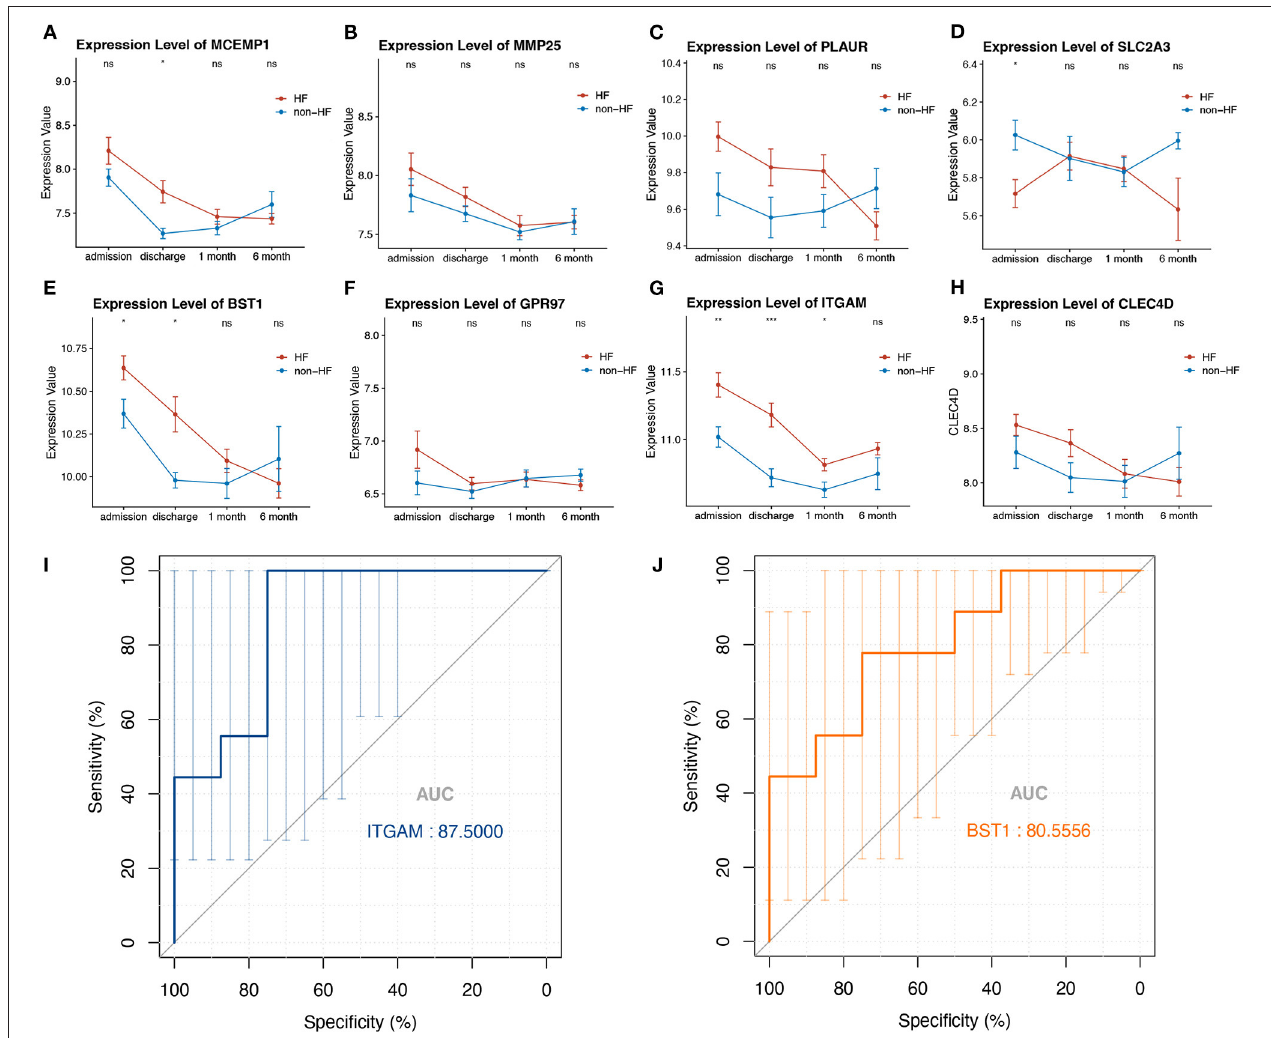
FIGURE 6 | (A–H) Gene variations over time for investigated hub genes in patients with post-STEMI HF and patients with non-HF at different time points after STEMI (on admission, discharge, 1 month, and 6 months). Red line: HF patients, black line: patients with non-HF. Bars in high and low represent the maximum and minimum gene expression values, respectively. Statistical significance: * p < 0.05; ** p < 0.01; *** p < 0.001, Wilcoxon rank-sum test. (I,J) ROC curves for ITGAM , and BST1 , respectively. AUC, area under the curve; ROC, receiver operating characteristic. The bars represented the area of 95%